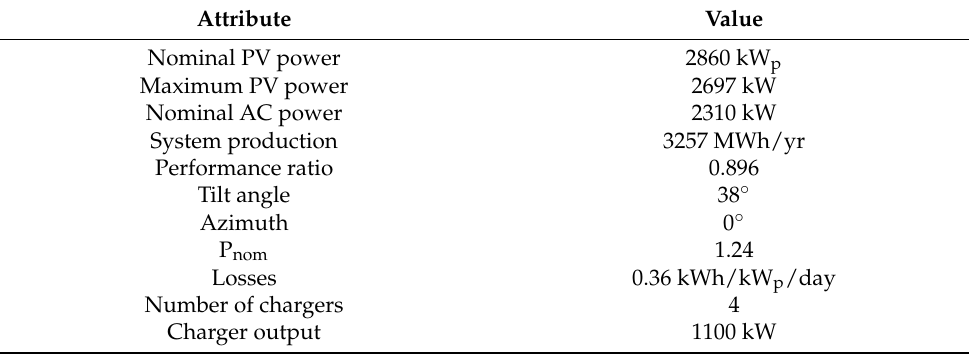
Table 2. Technical parameters of the PVEVCS.